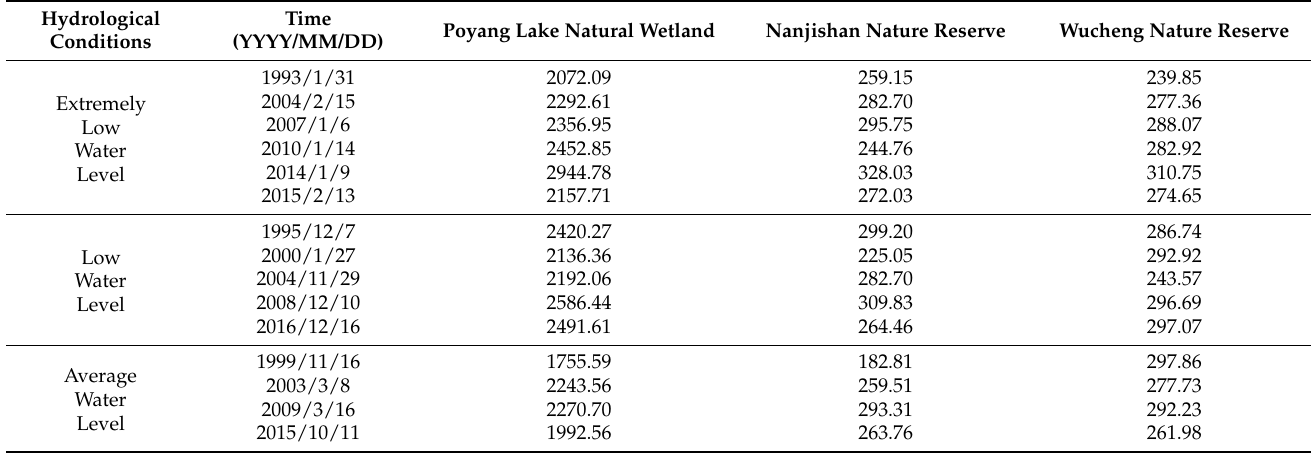
Table 5. Areas of crane habitats in the Poyang Lake wetland and two national nature reserves under various water level conditions (km 2